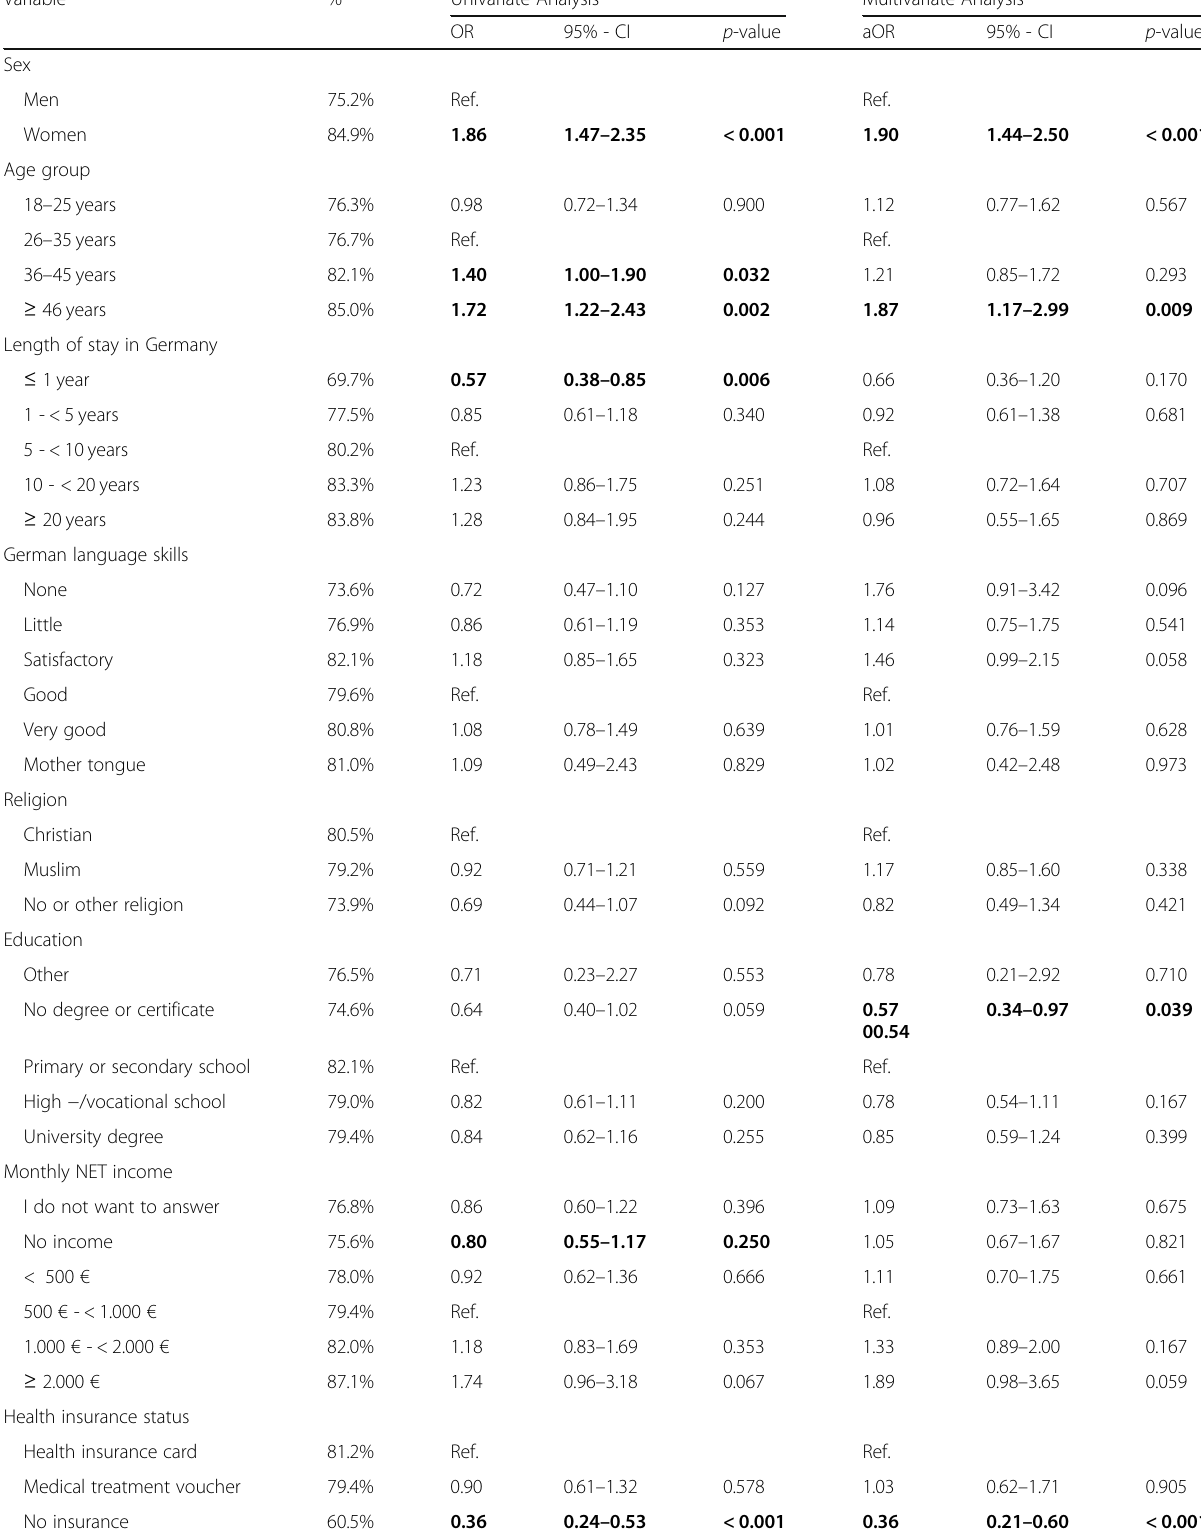
Table 6 Multivariate analysis on the last consultation of a physician or hospital (within one year = 1, over one year ago = 0), n =